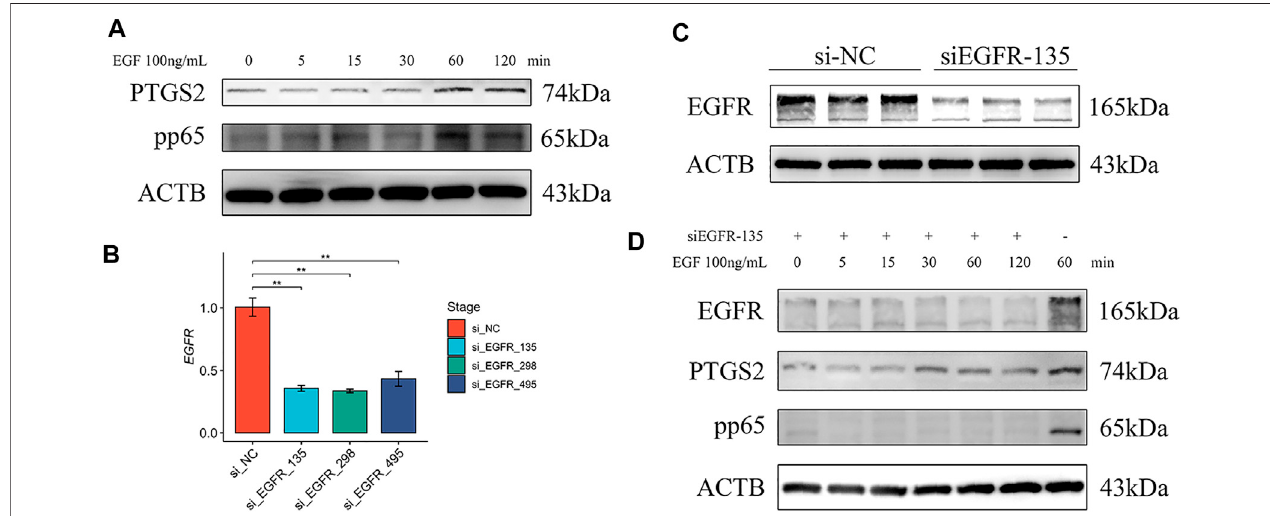
FIGURE 6 | EGFR regulated NF- κ B and PTGS2 in pTr cells. (A) Western blot results of pTr cells treated with EGF (100 ng/ml) for 0, 5, 15, 30, 60, or 120 min (B) EGFR real-timePCRresultsofpTrcellstransfectedwiththreesiRNAs. (C) WesternblotresultsofpTrcellstransfectedwithsi_EGFR_135. (D) WesternblotresultsofpTr cells treated with EGF (100 ng/ml) for 0, 5, 15, 30, 60, or 120 min after transfection using si_EGFR_135 and treatment with EGF (100 ng/ml) for 60